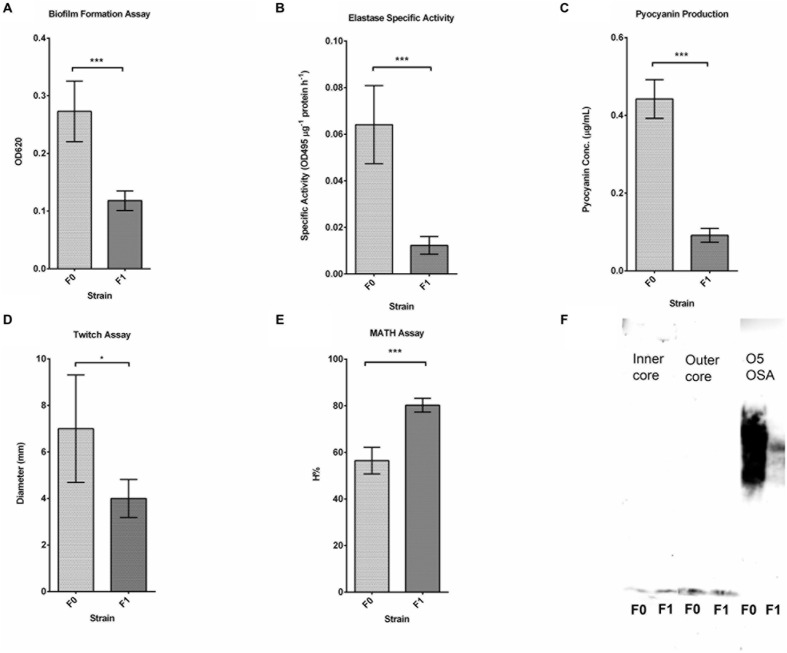
Results for phenotypic assays.
(A) Biofilm formation assay of three replicates of F0 and F1 strains; Student’s t-test. F1 cells have a significantly lower OD260 than F0, indicating fewer attached cells since fewer of them are stained. (B) Elastase assay of five replicates of F0 and F1 strains; Student’s t-test. F1 cells produce significantly lower elastase specific activity than F0. (C) Pyocyanin production assay of five replicates of F0 and F1 strains, measured concurrently with elastase activity; Student’s t-test. F1 cells produce significantly lower amount of pyocyanin than F0. (D) Twitch assay for seven replicates of F0 and F1 strains; Student’s t-test. F1 cells have a significantly lower twitching ability than F0. (E) MATH assay of 12 replicates of F0 and F1 strains; Student’s t-test. F1 cells have a significantly higher H% than F0 cells. (F) Western blot analysis of LPS preparations from F0 and F1 strains, tested using antibodies for inner, outer core and OSA. ∗p < 0.05, ∗∗p < 0.005, ∗∗∗p < 0.0005.